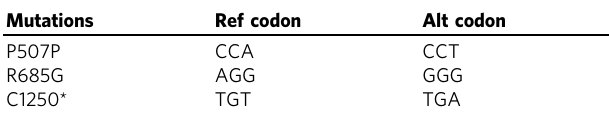
A table summarizing the mutations in the spike that were acquired during serial passaging of rVSV- Δ G-spike, showing the synonymous mutation (upper row), the nonsynonymous mutation at the S1/S2 cleavage site (middle row), and the nonsense mutation introducing a stop codon leading to a truncation of 24 amino acids at the cytoplasmic tail of the S protein (bottom row). An asterisk (*) indicates stop codon. Ref codon reference codon, Alt codon altered codon.